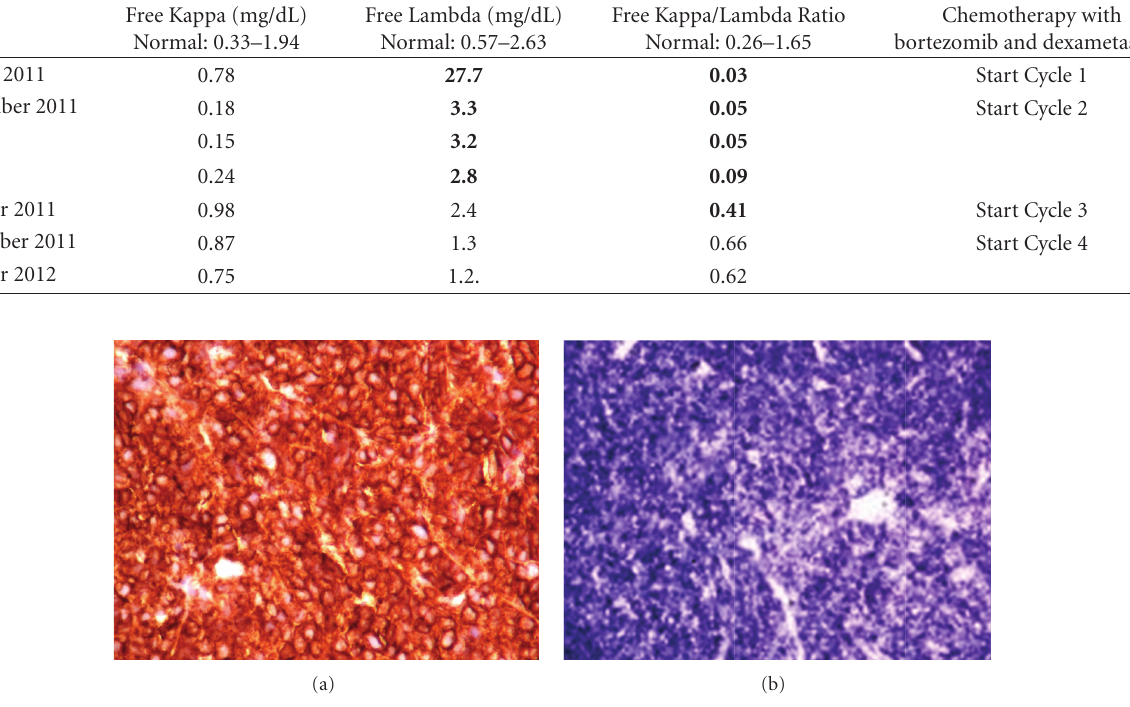
Figure 2: (a) Diagnosis of extramedullary plasmacytoma confirmed by immunoperoxidase staining for CD138 and (b) in situ hybridization for lambda chains which confirmed plasma cell